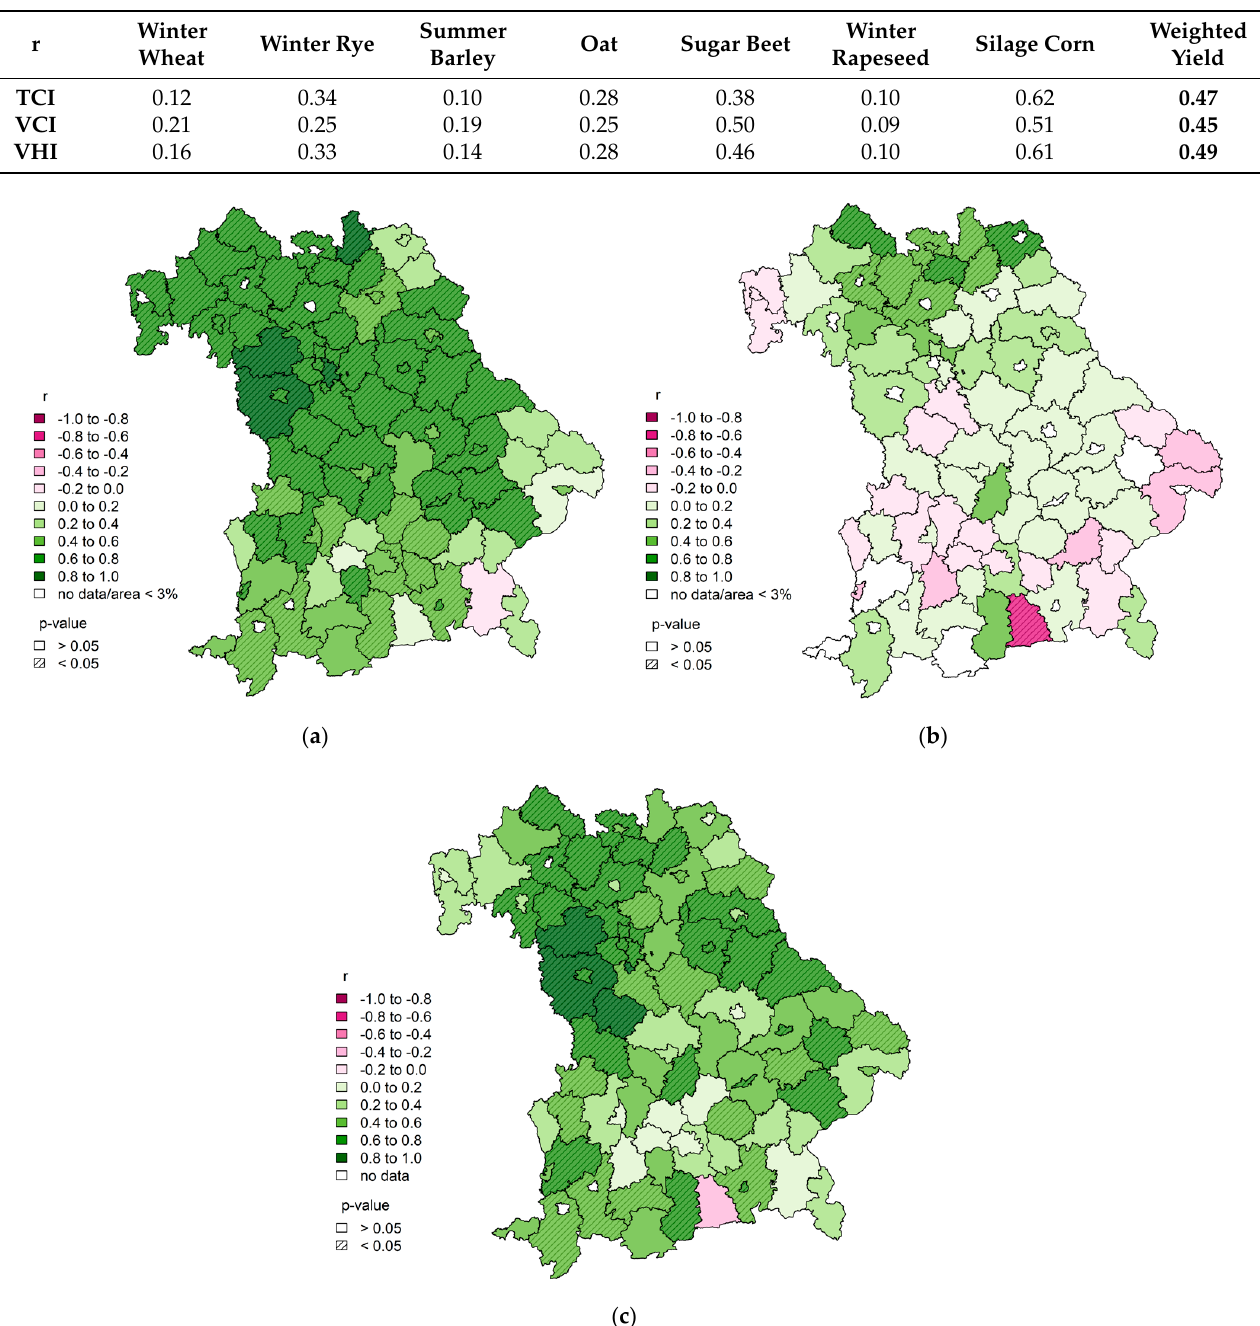
Table 6. Bravais-Pearson correlation coefficients (r) between crop-specific mean drought index values and the respective annual field crop or weighted yield anomalies (county level). All correlation coefficients are statistically significant ( p -value < 0.05). The corresponding scatterplots between weighted yield anomaly and weighted annual mean drought index are included in Figure S8.